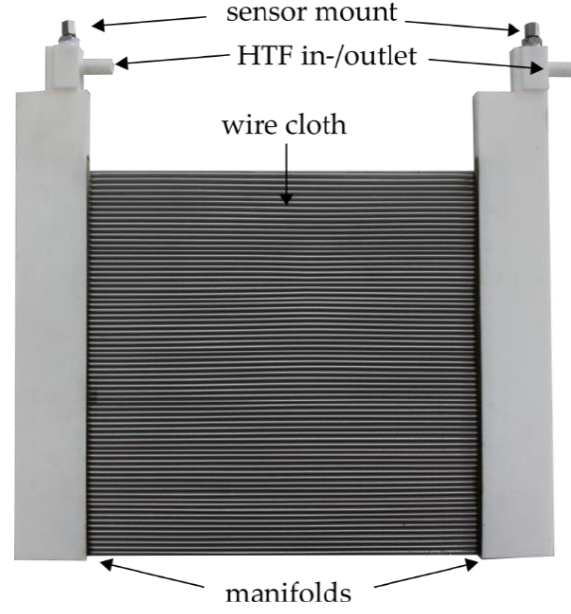
Figure 2. Heat exchanger made of wire cloth with manifolds.